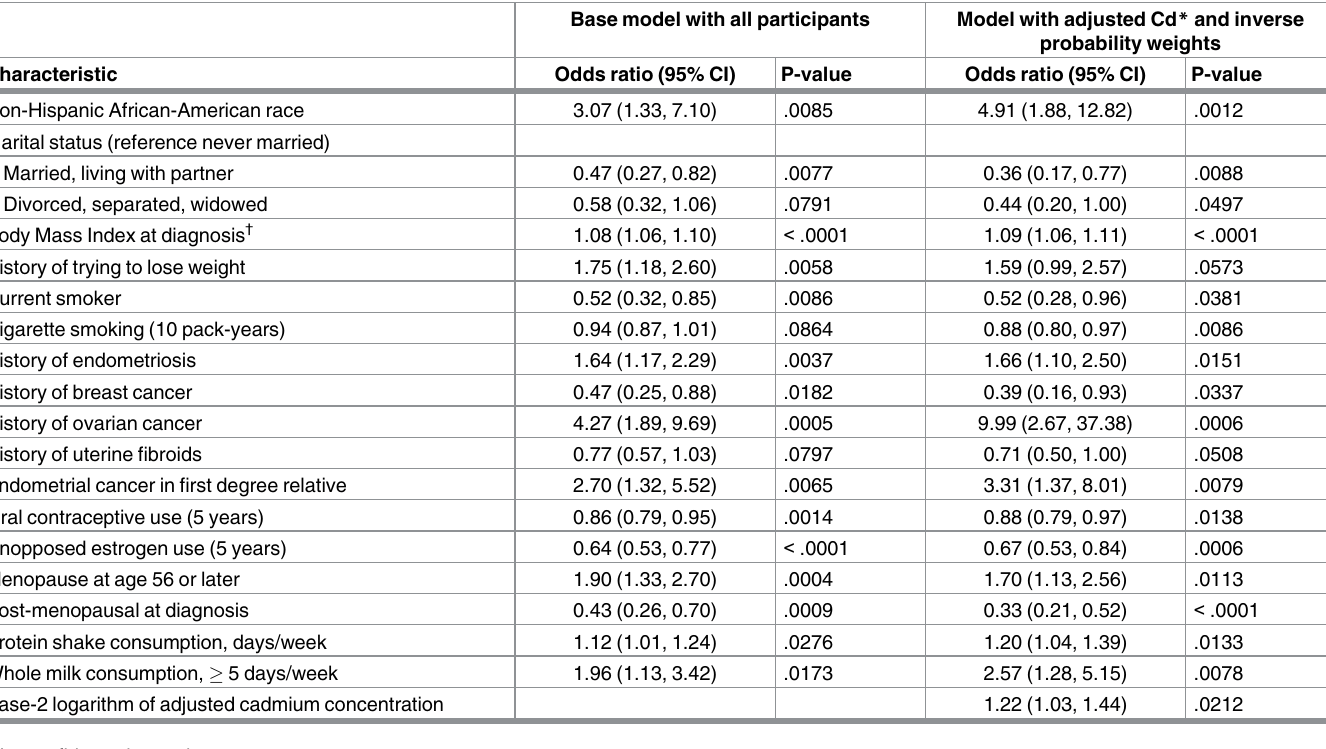
Table 2. Multivariable conditional logistic regression of risk factors for endometrial cancer. Base model with all participants Model with adjusted Cd * and inverse probability